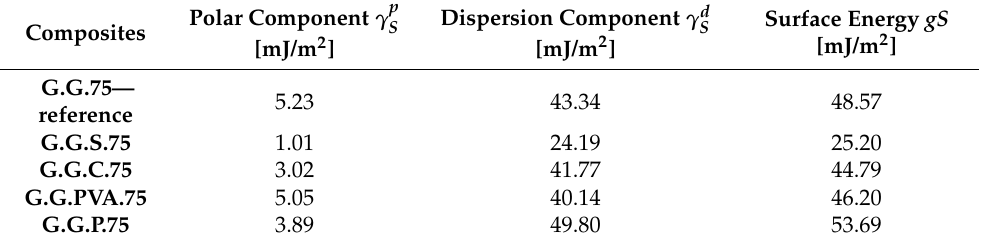
Table 7. Comparison of the polar component, dispersion component, and surface energies of samples.